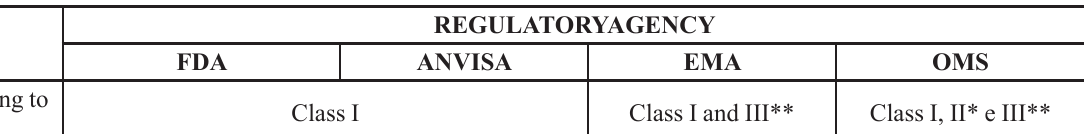
TABLE II - Main requirements for obtaining biowaiver based on BCS